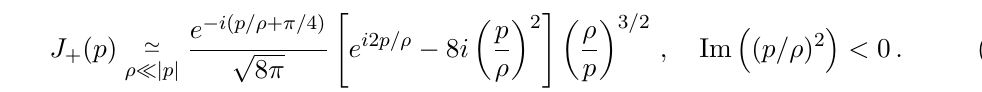
Figure 5 . Contour plot in the plane ( M/ρ, Γ /M ) of the common logarithm of the absolute value of the Green’s functions log | G A ( y 0 , y 0 ) | (left panel), log | G A ( y 0 , y 1 ) | (middle panel) and 10 10 log | G A ( y 1 , y 1 ) | (right panel). The (red) dots stand for the positions of the poles of the Green’s 10 functions as predicted by the analytical formula of eq. (3.46). The contour lines form small cir- cles around the poles of G A ( y α , y β ) (those circles with red dots), or circles around the zeros of G A ( y α , y β ) (those circles with no red dots). We have considered A 1 = 35 . numerator of G ( y , y ) , in eq. (3.24), behaves, for large momentum, 0 0 A